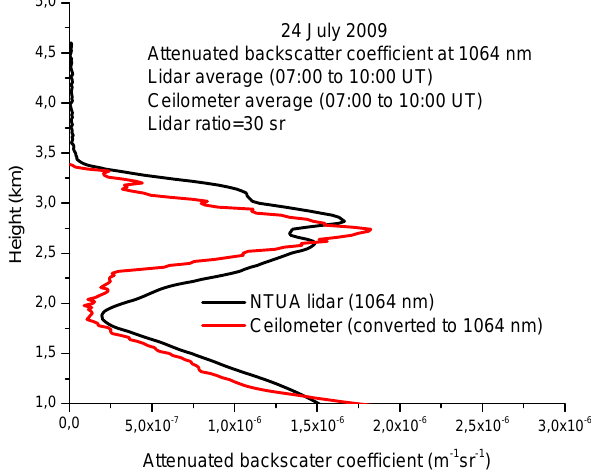
Fig. 7. Comparison of the attenuated backscatter coefficient pro- files (in m − 1 sr − 1 ) obtained by the Vaisala ceilometer and NTUA Raman lidar system (07:00–10:00UT) on 24 July